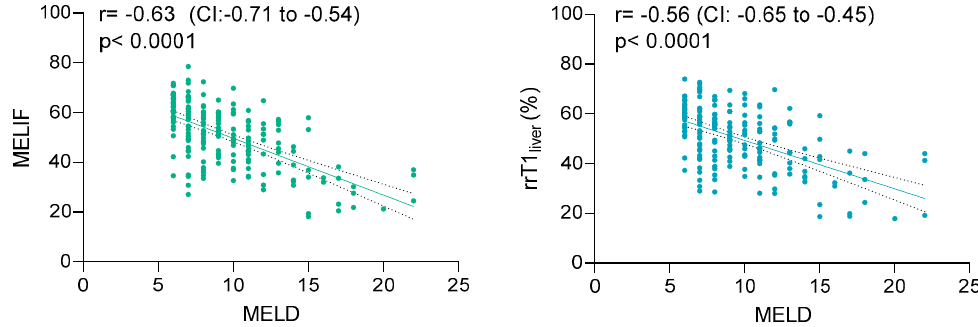
Figure 3. Pearson’s correlations (r) of the MELIF score ( left ) and rrT1 liver ( right ) with the MELD score. The correlation coefficient with the 95% confidence interval (CI) is given in the upper left corner of each graph. Simple linear regression was used (straight line), and the CI is shown as a dotted line.